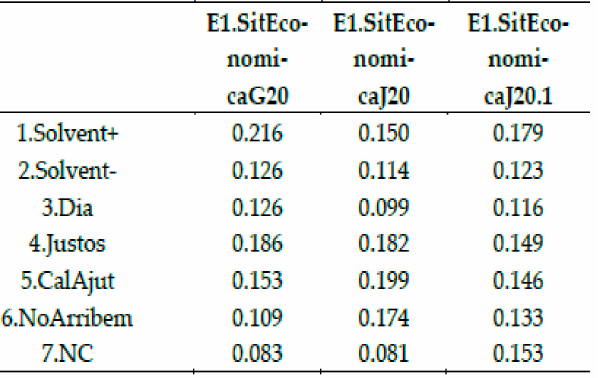
Figure 24. Temporal proportions table of variable E1.SitEconomica (economic situation) per levels. Each column represents the observed distribution of the variable E1 in one timestamp.